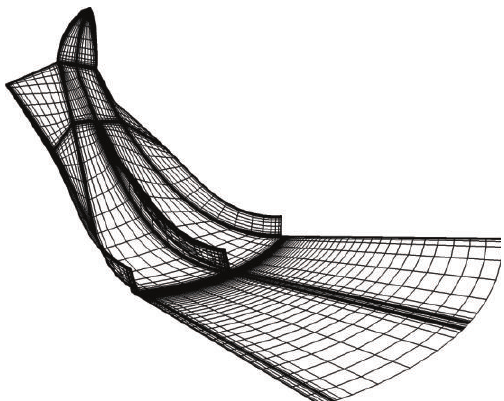
Figure 3: Surface grid in the impeller and diffuser. For the sake of clarity, the shroud is not shown and only every other grid line is